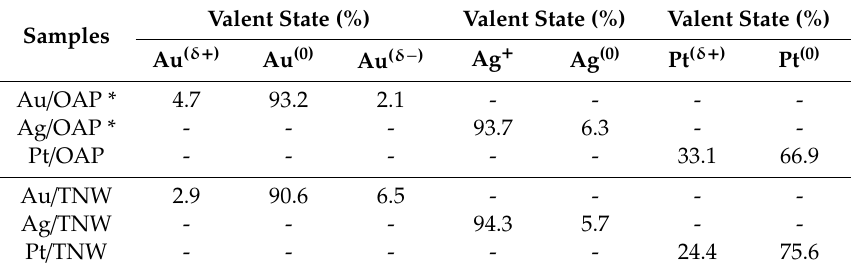
Table 2. Fraction of oxidation states of Au, Ag and Pt from deconvolution of XPS peaks of Au 4f 7 / 2 , Ag 3d 5 / 2 and Pt 4f 7 / 2 .